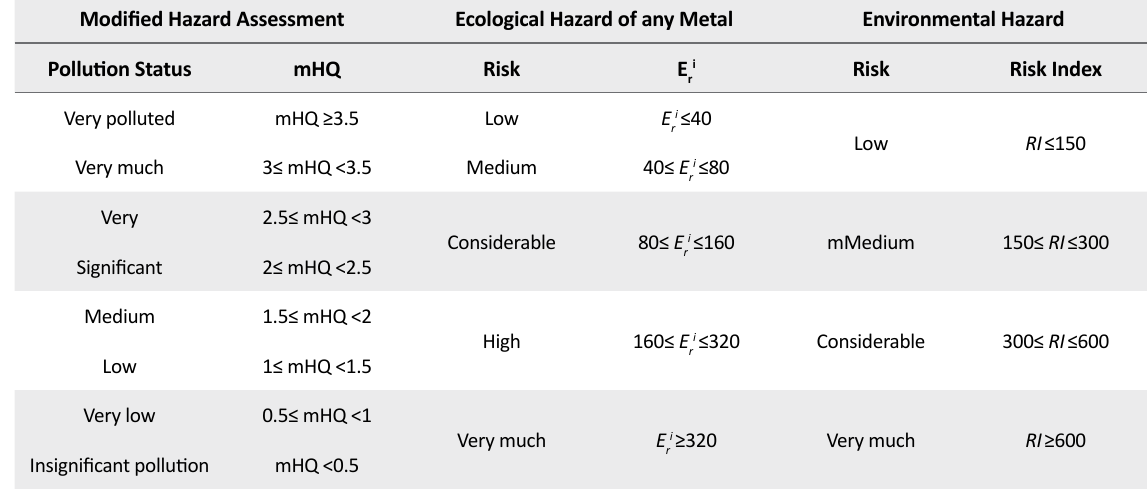
Table 2. Ecological hazard assessment and modified Hazard Quotient (mHQ) of heavy metals [23]